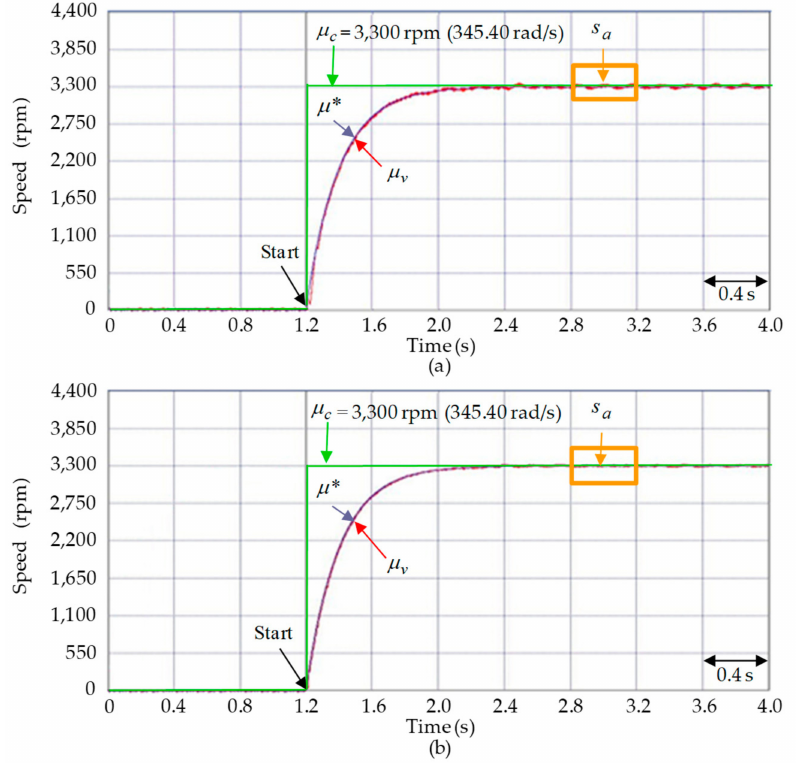
Figure 10. Speed responses via experimental results for the ISM driving the rice milling machine system in test JB by adopting the controllers: ( a ) TA; ( b )